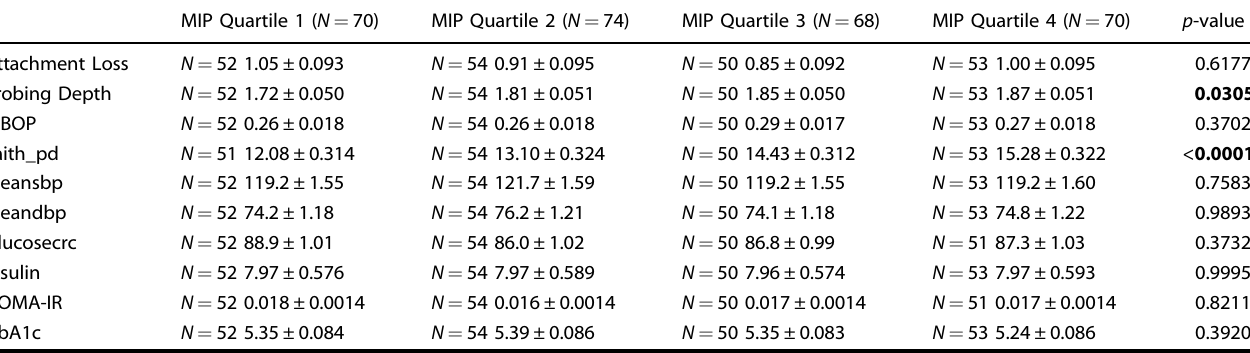
Table 6. Quartiles of Microbial Indicator of Periodontal Disease (MIP) in saliva and multiple measures of periodontal disease and markers of cardiometabolic